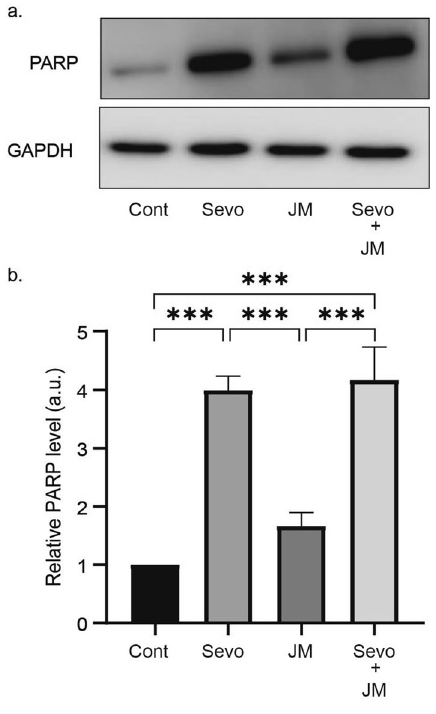
Figure 3. Combined administration of JM-1232(−) and sevoflurane does not potentiate apoptosis in P6 mice compared with sevoflurane administration alone. Western blot analysis showed that the amount of cleaved PARP detected stet for co-administration and single-administration of sevoflurane and/or JM-1232(−). ( a ) Protein extracts of the forebrain of P6 mice were processed and analysed for cleaved PARP immunoreactivity ( b ) and normalised against GAPDH. JM-1232(−) 0 mg kg −1 + sevoflurane 0% (n = 6); JM-1232(−) 10 mg kg −1 + sevoflurane 0% (n = 6); JM-1232(−) 0 mg kg −1 + sevoflurane 2% (n = 6); JM-1232(−) 10 mg kg −1 + sevoflurane 2% (n = 6). A comparison of the means among groups was performed using two-way ANOVA followed by Tukey post hoc test (*** p < 0.001). Error bars are SEM. Full-length blots are presented in Supplementary Fig.